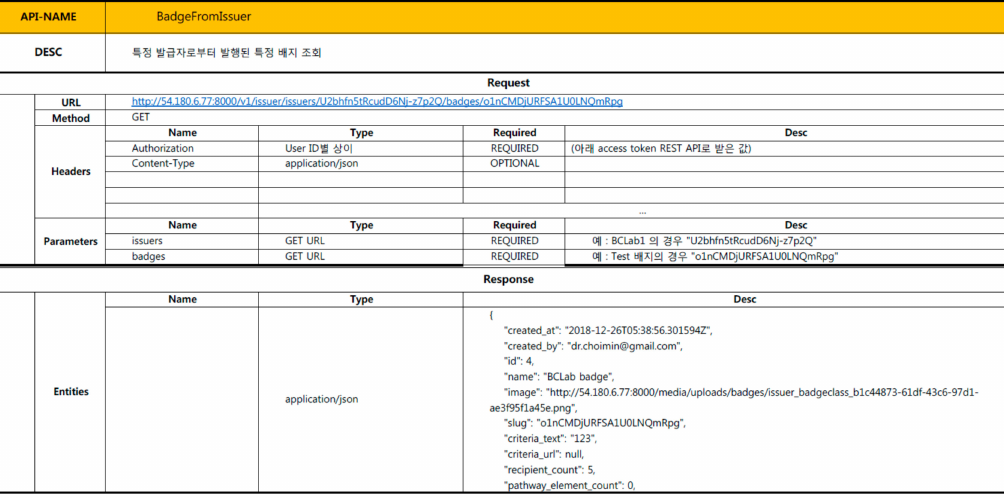
Figure 14. REST API for listing badges from a certain